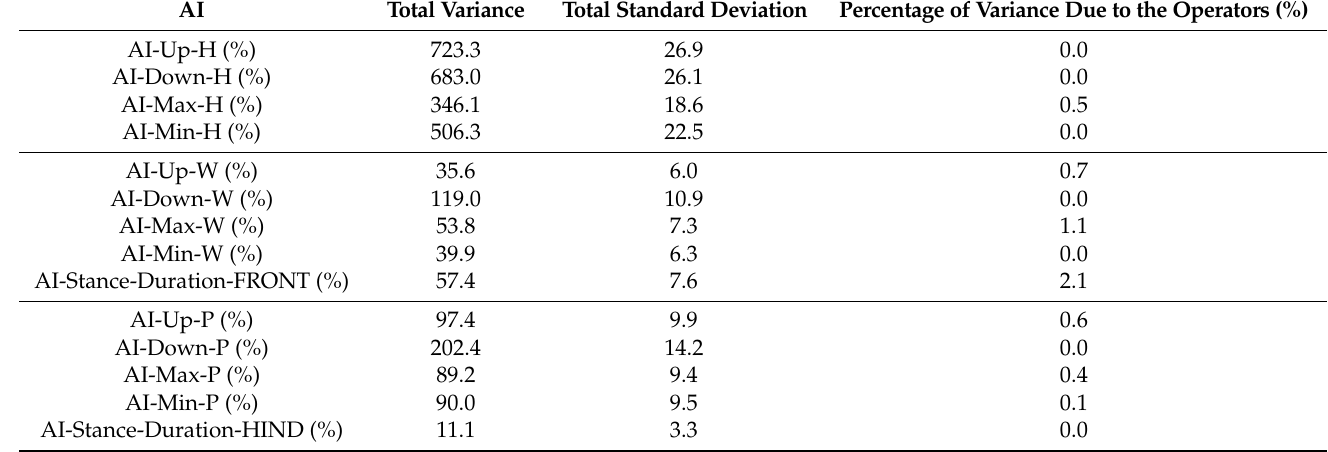
Table 1. Total variance, total standard deviation and percentage of variance due to the operators (calculated out of the total variance) for four asymmetry indexes (AI -Up, -Down, -Max and -Min) cal- culated on the head (H), the withers (W) and the pelvis (P) for 48 repeated measurements (4 operators, 3 horses, 4 repetitions) performed on a straight